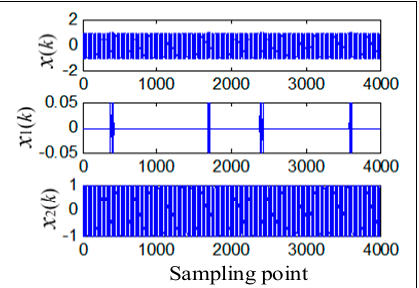
Figure 1. Original digital signals ( ) x k , 1 ( ) x k